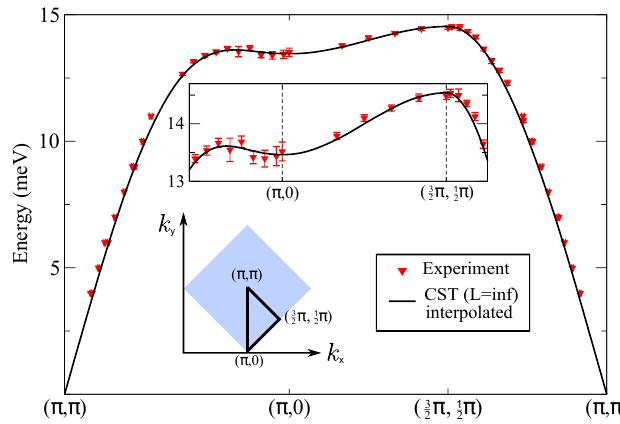
Figure 2: One-magnon dispersion. Dispersion along a representative path through the magnetic Brillouin zone (in light blue) comparing the dispersion obtained theoretically by CST with the experimental data (red triangles with error bars) from Ref. [ 16 ] for the coupling value J = 6.11 ( 2 ) meV. The inset shows the convincing agreement around the roton minimum at ( π ,0 ) . The theoretical data are extrapolated to infinite system size on a mesh of wave vectors and interpolated between them which yields the solid line. (The lattice constant is set to